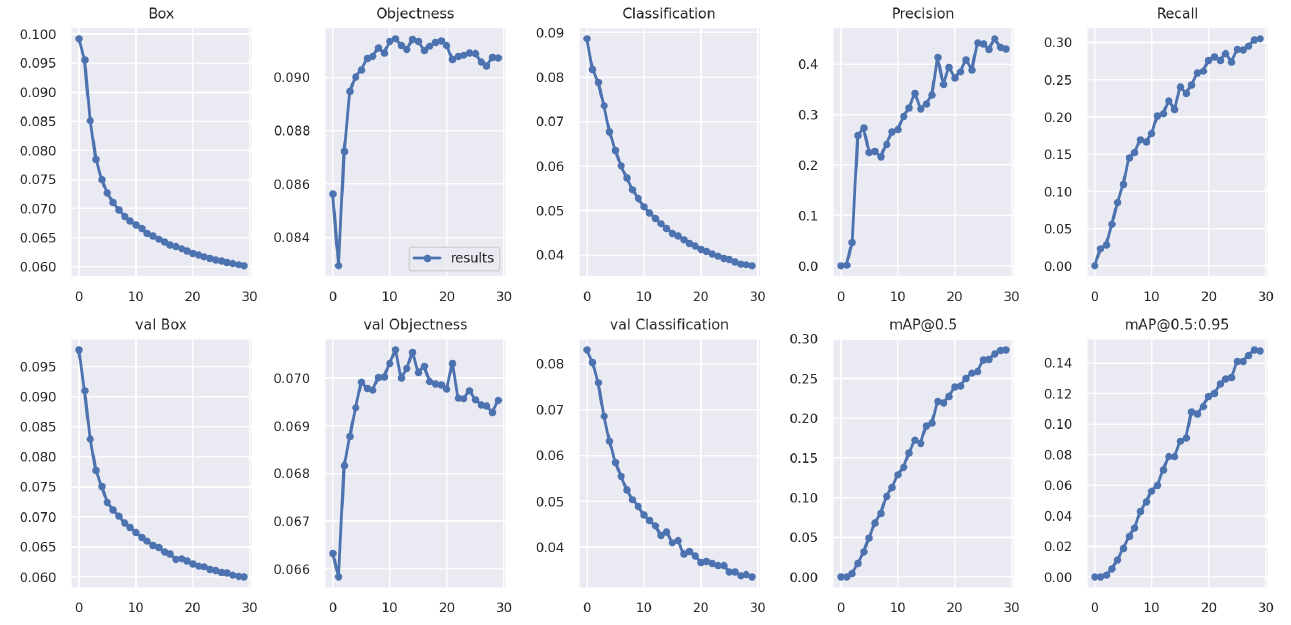
Figure 3. Illustration of the performance curves during the search process. The supernet is trained for 30 epochs.